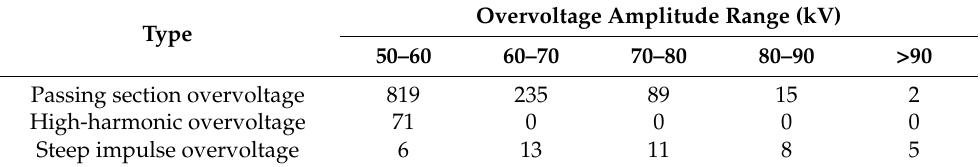
Table 1. Overvoltage amplitude distribution.